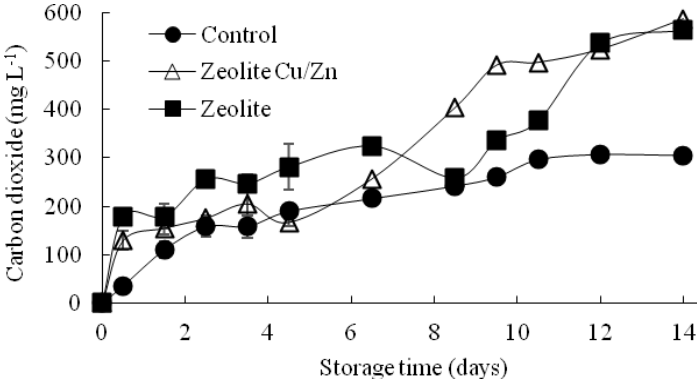
Figure 6. Carbon dioxide concentration as a function of storage time for di ff erent treatments.